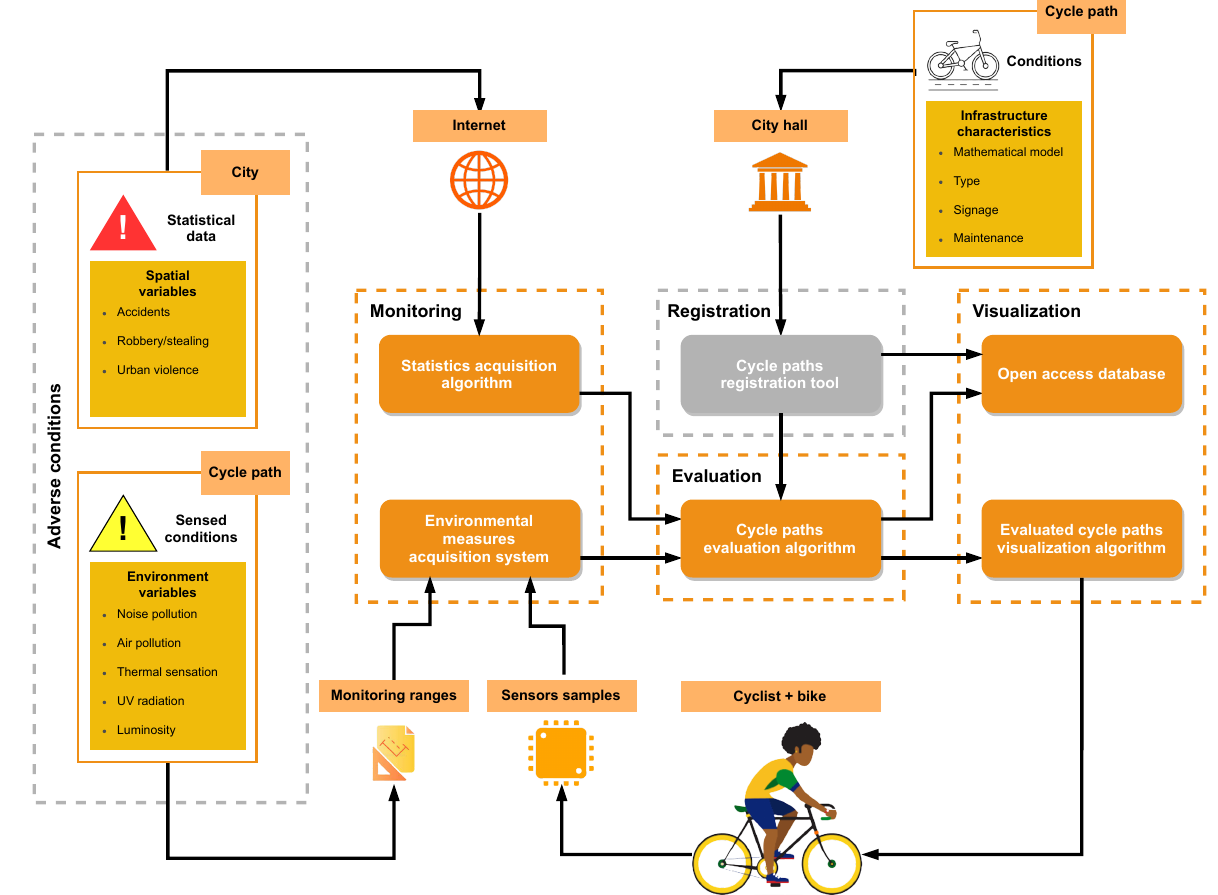
Figure 1. The processing cycle when assessing the quality of cycling